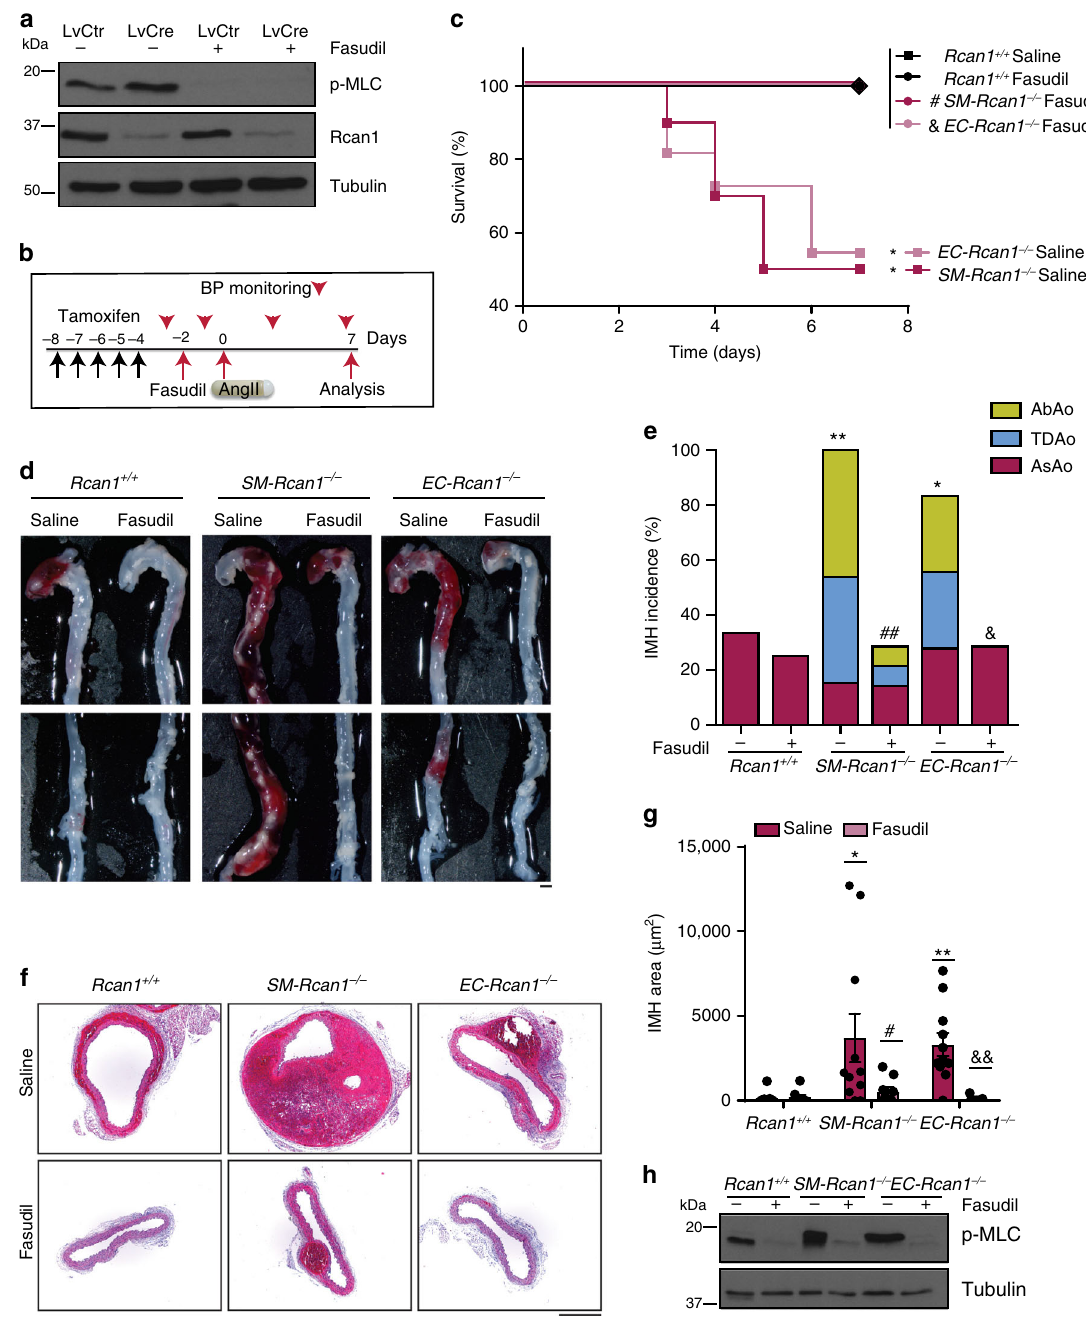
Fig. 7 ROCK mediates MLC activation and aortic disease. a Representative p-MLC, Rcan1, and tubulin immunoblots of Rcan1 fl / fl vSMCs transduced with Cre-encoding or control lentivirus and treated with the ROCK inhibitor Fasudil (30 µ M) for 1 h ( n = 3 independent experiments). b Experimental timeline. Black arrows, tamoxifen injection. A group of mice was treated with Fasudil (1 mg per ml in drinking water) starting 2 days before 7-day treatment with AngII. Red arrowheads, BP measurements. Red arrows, Fasudil start of treatment ( − 2), AngII osmotic minipump implantation (0), and